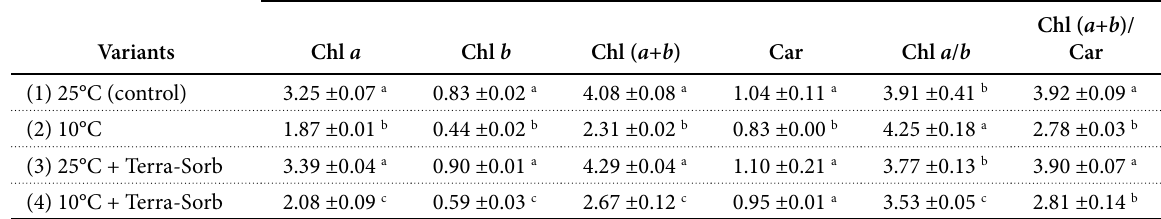
The data presented are sample means ± SD . Different letters (a, b, and c) following the SD values indicate significant differences at p <